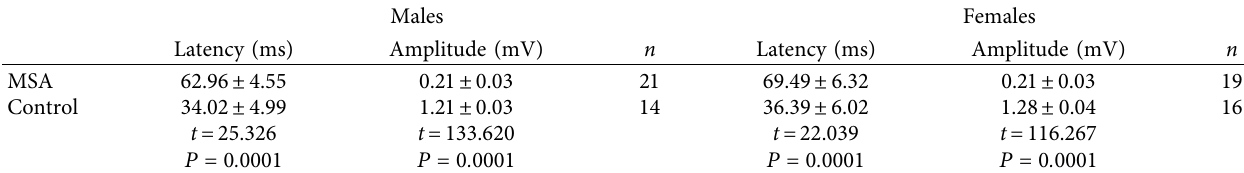
Table 2: Comparison of mean BCR latency and amplitude between the MSA and control groups.